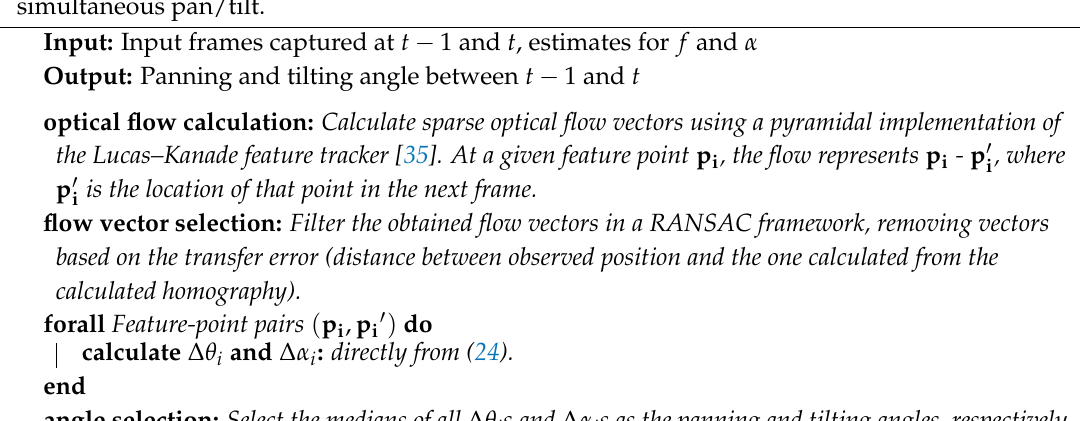
Algorithm 3: Determination of the panning and tilting angles between successive frames with simultaneous